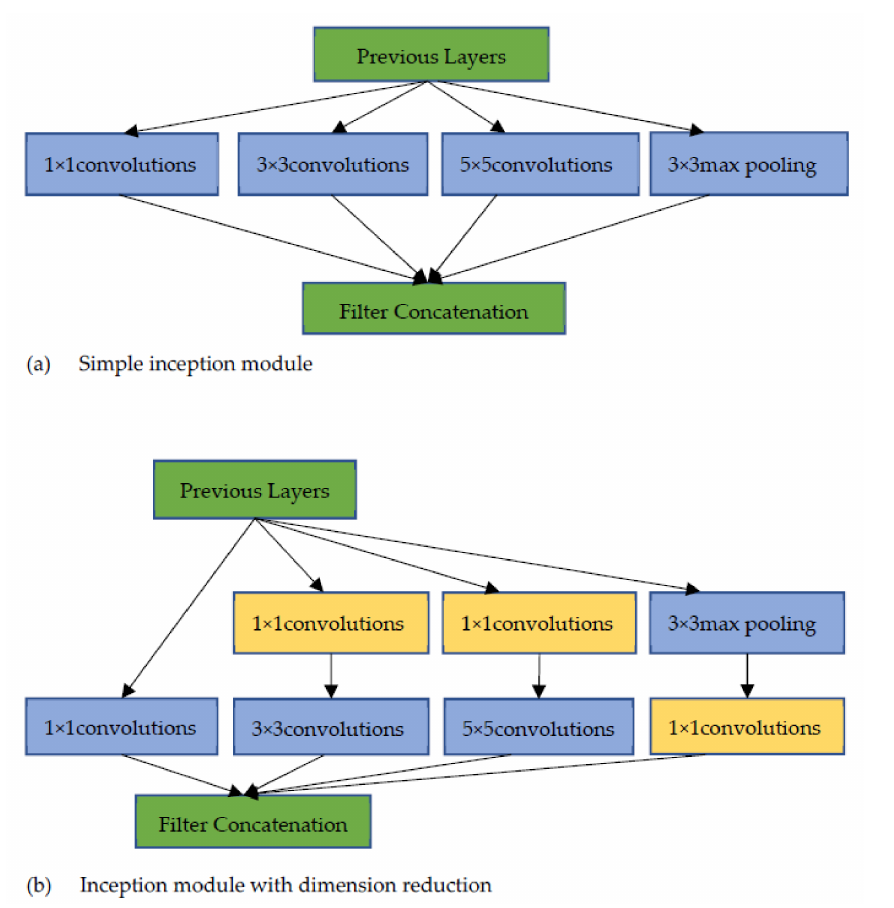
Figure 4. Inception